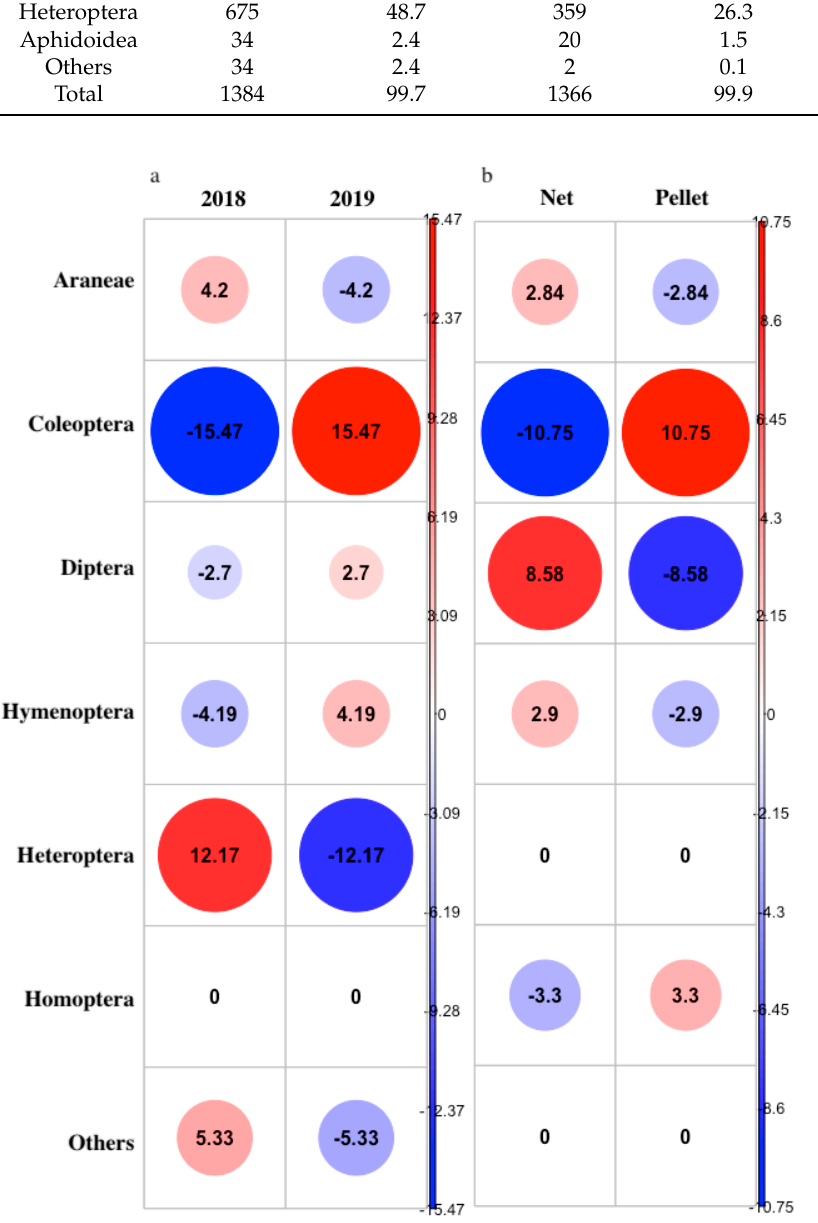
Figure 4. The charts show Pearson’s Standardized Residuals (numbers within the circles), obtained through χ 2 test of independence on permuted dataset. Greater positive deviation from independence (positive association) is indicated with darker hues of RED; greater negative deviation from independence (negative association) is indicated with darker hues of BLUE. ( a ) Arthropods collected in the Mirandola breeding site of Reed Warblers in 2018 and 2019; ( b ) Comparison between the collection in 2019 and the prey items found in the bird